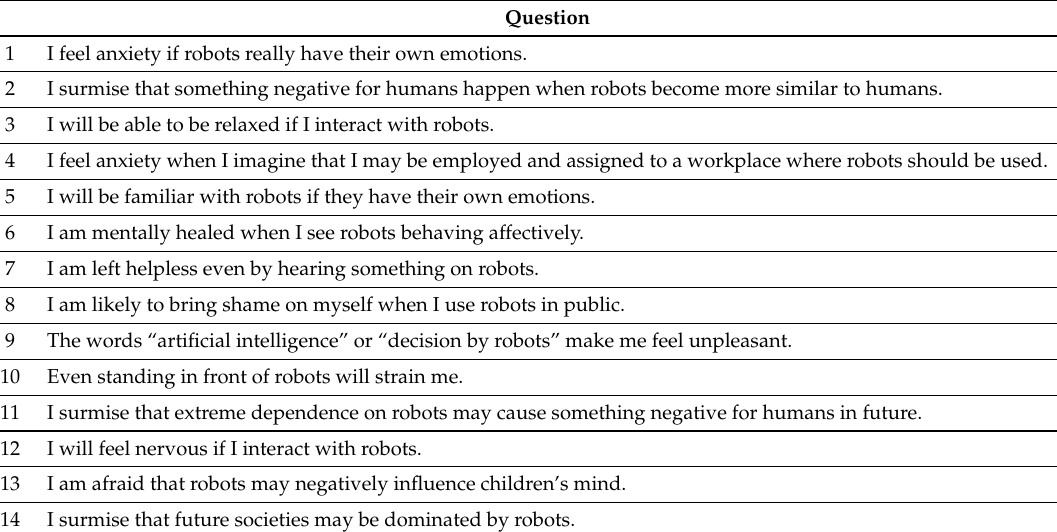
Table 1. Negative Attitudes towards Robots Scale (NARS)